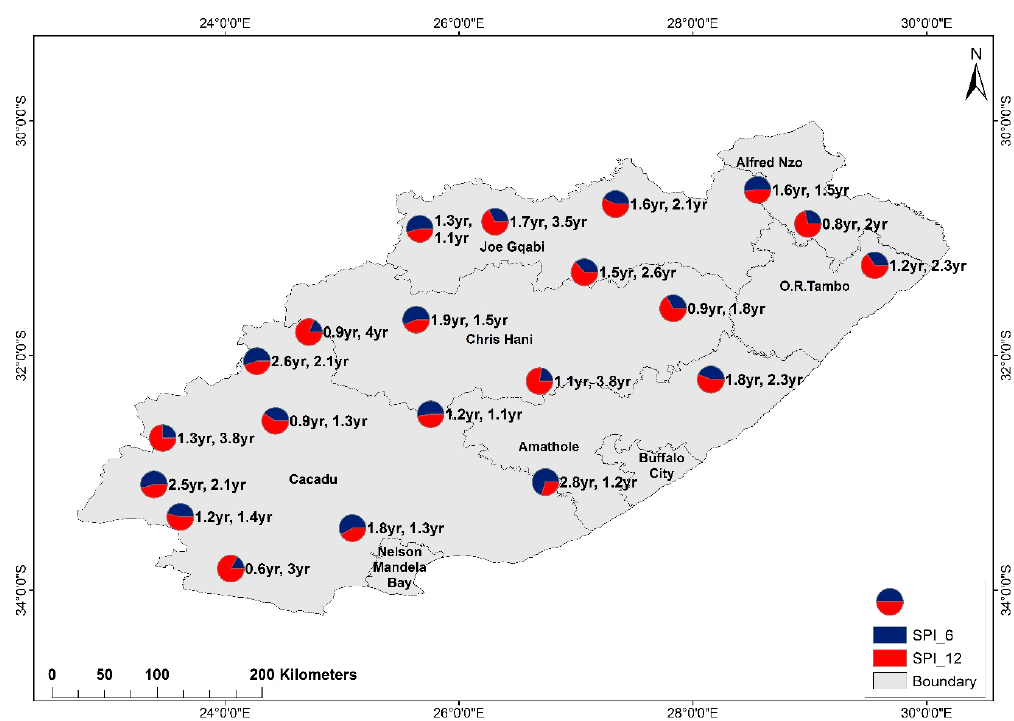
Figure 4. Spatial contrasts of maximal drought duration (in years) across the Eastern Cape province.